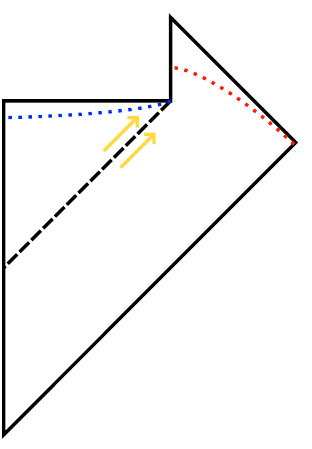
Figure 5 . The bulk dynamics for information loss: exterior Hawking modes end up in the Hawking radiation (the red dotted line), while interior Hawking modes (and also whatever matter formed the black hole) end up in a baby universe (the blue dotted